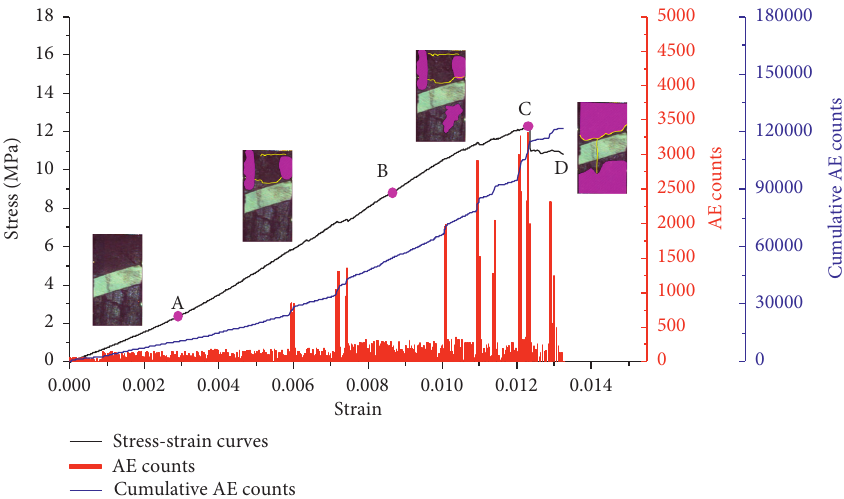
Figure 5: Stress-strain curve and acoustic emission monitoring curve of composite specimens with a 20 ° dip angle (A20-1).